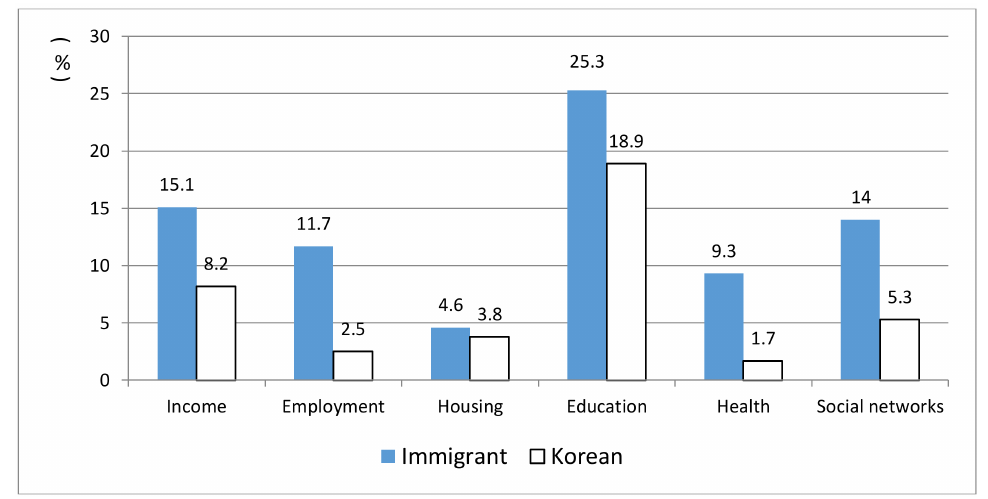
Figure 2. Comparisons of the social exclusion experienced by multicultural and Korean